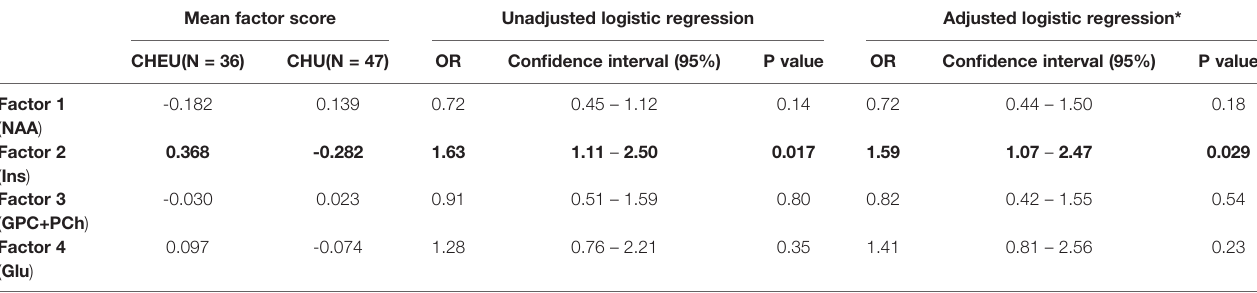
TABLE 4 | Logistic regression analysis of factor scores as predictors for HIV exposure.